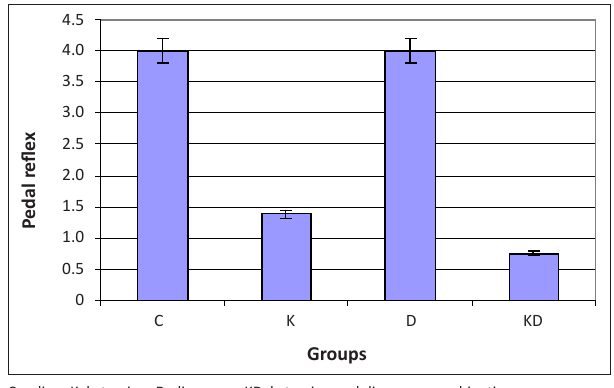
FIGURE 2: The comparison of pedal reflex across the groups of pigeons treated with normal saline, ketamine, diazepam, and a ketamine and diazepam combination, where a score of 0.0 represents a weak reflex and 4.0 represents a strong reflex.